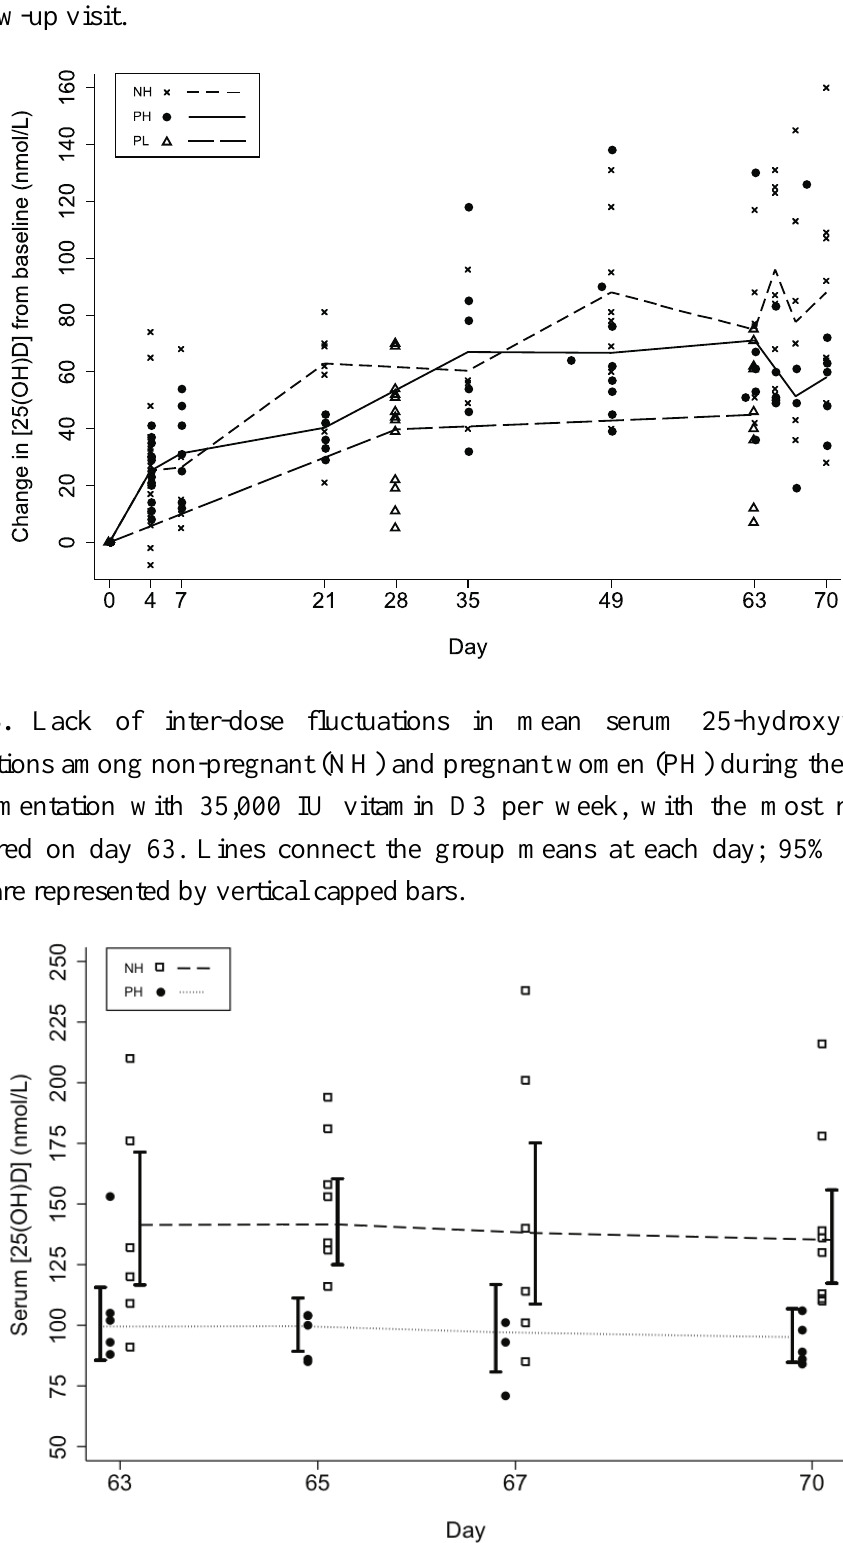
Figure 3. Changes in serum 25-hydroxyvitamin D concentration from baseline resulting from weekly vitamin D3 administration to non-pregnant women who received an initial dose of 70,000 IU and then 35,000 IU/week thereafter (NH), pregnant women who received an initial dose of 70,000 IU and then 35,000 IU/week thereafter (PH), and pregnant women who received 14,000 IU/week (PL). Lines connect the group means at each follow-up visit.